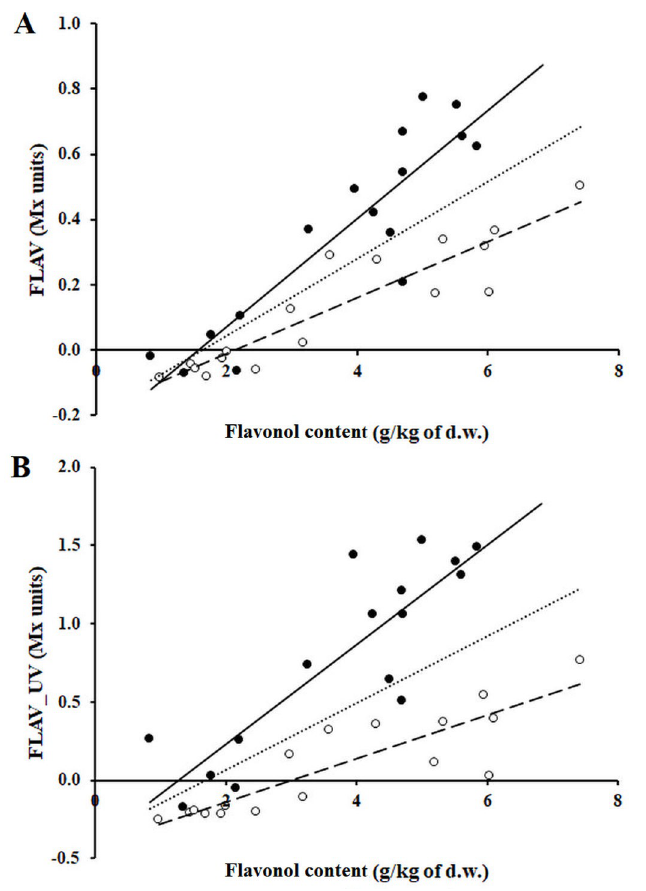
Fig 1. Correlation curve between spectroscopic indices and the berry skin flavonol concentration measured analytically. The Multiplex measurements were taken in 2018 at the Tramin valley vineyard (north-south oriented). The total flavonol compounds were extracted from the skin of previously Mx flashed berries and analysed by HPLC-MS. The wet chemistry data were correlated to FLAV (A) and FLAV-UV (B) indices. Empty ( � ) and solid (•) dots represent pre- and post-veraison samples, respectively. Trend lines for the whole set of data (dotted-line) are displayed, the fitting curve equations are: A) FLAV, y = 0.1181x – 0.1923, R 2 = 0.62 and B) FLAV_UV, y = 0.2126x – 0.3554, R 2 = 0.43. The equations for groups of data are: A) y = 0.0859x – 0.1818, R 2 = 0.84 and y = 0.1654x – 0.2572, R 2 = 0.81; B) y = 0.1383x – 0.4143, R 2 = 0.76 and y = 0.3175x – 0.4004, R 2 = 0.75, for pre- (dashed line) and the post-veraison (solid line) periods,